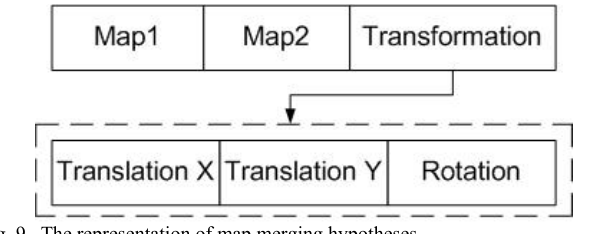
Fig. 9. The representation of map merging hypotheses There are two possible tasks that the Local map merging module can receive – map merging by using heuristics or map merging by using the positional information of the robots. As the information available is different, each of these cases should use a different map merging approach.